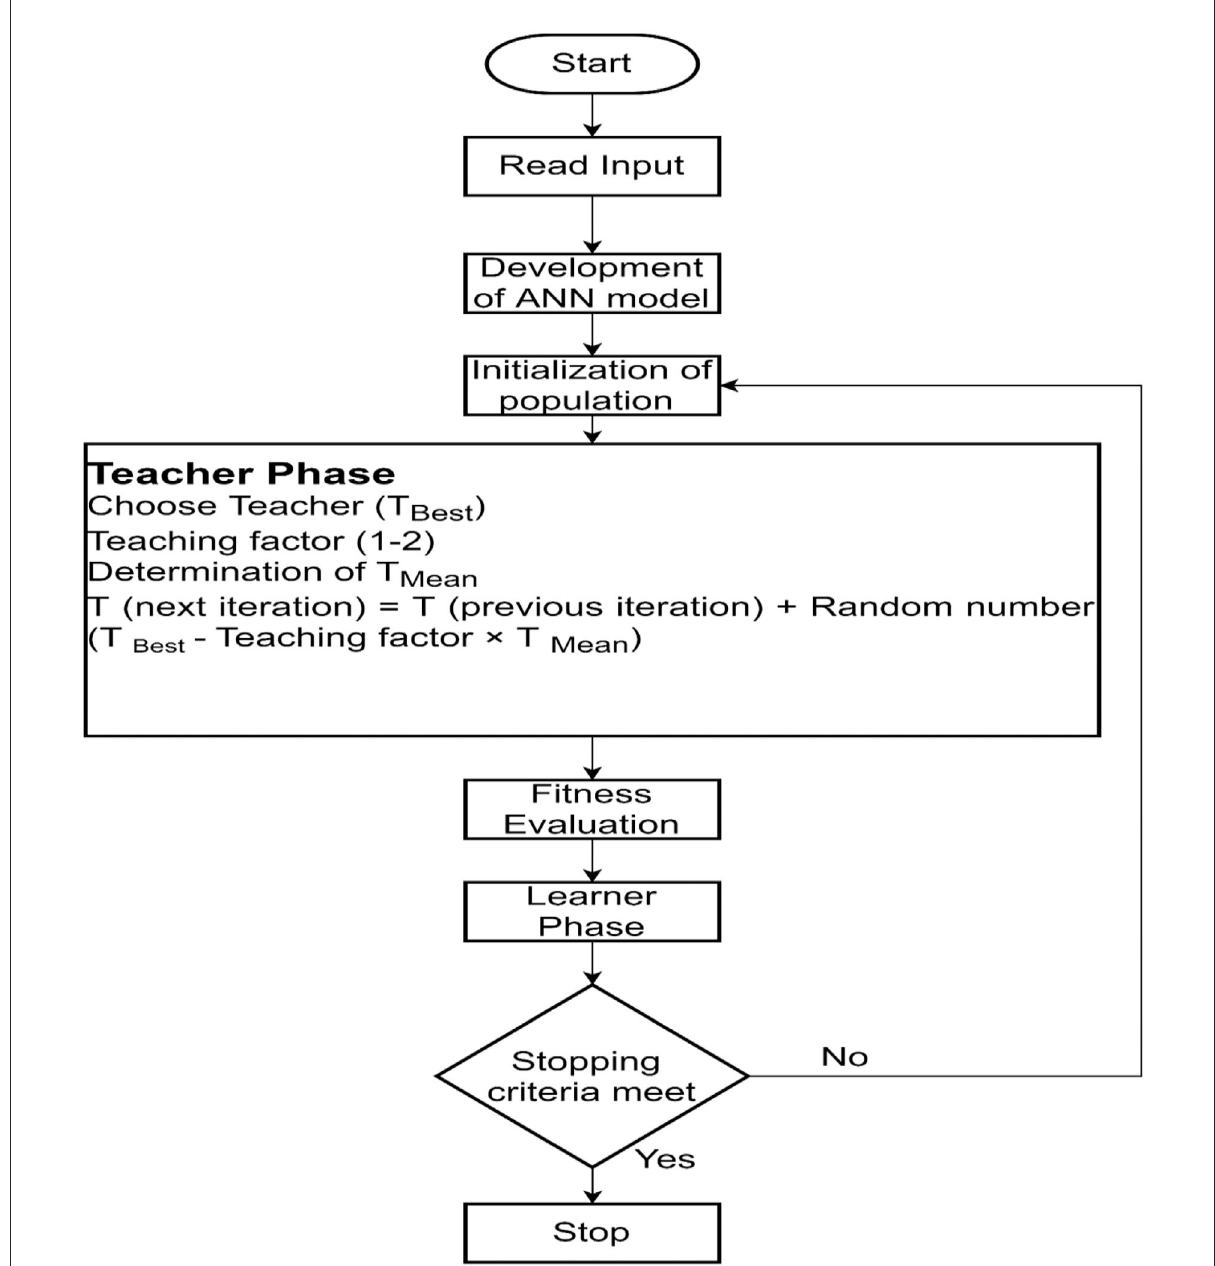
FIGURE1 Flowchart for the proposed ANN-TLBO